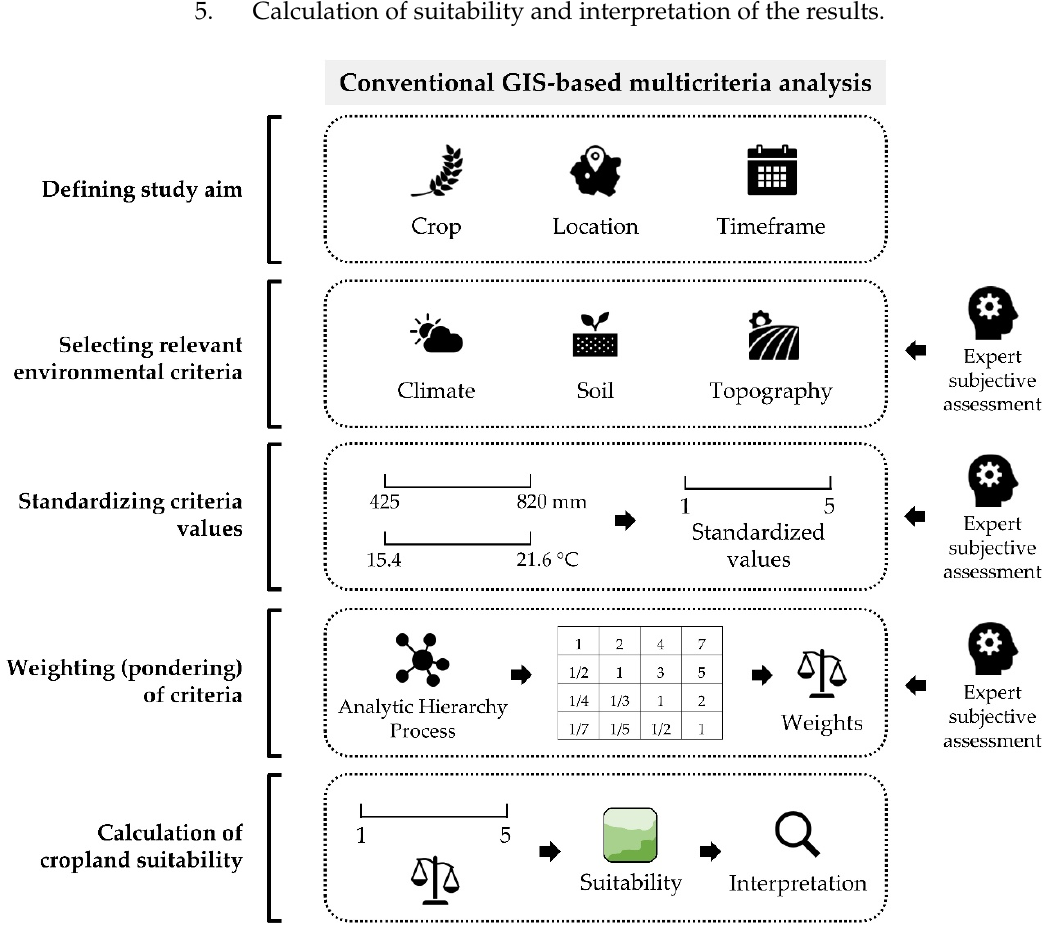
Figure 3. The conventional procedure of GIS-based multicriteria analysis for cropland suitability prediction.